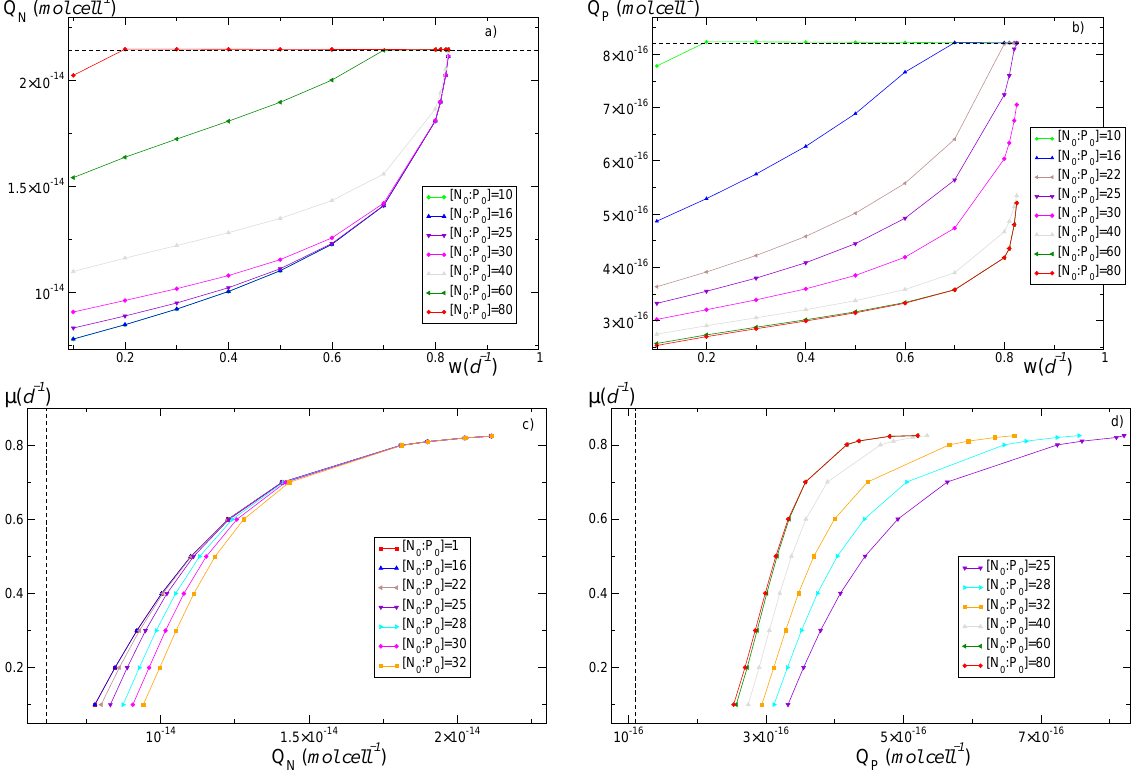
Fig. 7. Upper row: variation of the nitrogen and phosphorus quotas with dilution rate (dashed line: maximum effective values). (a) Q N shows linear behavior or convexity for the different input ratios; for very high ratios, the quota saturates at its maximum value. (b) Q P shows a similar behavior, but non-monotonicity is also possible for high relative phosphorus concentrations (low input ratio); that is the case of the [ N 0 ] : [ P 0 ] = 16 curve at high dilution rates, although the parametrization used here complicates a clear observation of that behavior (small values of the half-saturation constant, for instance, provide a more marked non-monotonicity, with clearer decline regimes for Q P ). Dependence of the growth rate µ on nutrient quota Q N or Q P are depicted in panels ( c ) and ( d ), respectively. Only the range of ratios for which Q N or Q P influence µ are shown in each panel (dashed lines: minimum value for the quotas, Q min ). Note the saturating shape of µ , reaching a maximum µ max = 0 . 825 ± 0 . 005. For extreme input ratios, curves do not show any dependence on the input ratio (e.g. [ N 0 ] : [ P 0 ] < 22 in ( c )). For intermediate input ratios, the value of the quotas at which µ reaches its minimum and maximum values change with the relative input